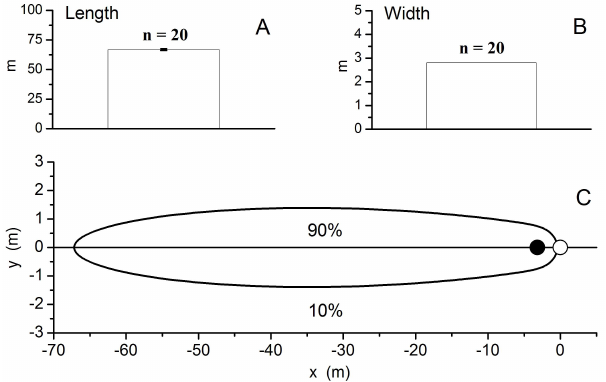
Fig. 9. The estimated length, width and shape of the eddy correla- tion footprint are shown in (A, B) , and (C) , respectively. The error bars represent standard error and n represents the number of 0.25h measuring periods. (C) shows the footprint or the area that con- tributes 90% of the flux (note the difference in axis scales). The open circle represents location of the eddy correlation instrument and the solid circle indicates the point of maximum flux contribu-